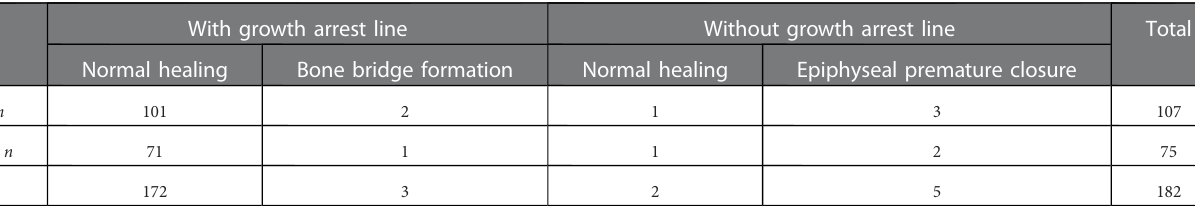
TABLE 4 Treatment result of patients with epiphyseal type 0 – 1.